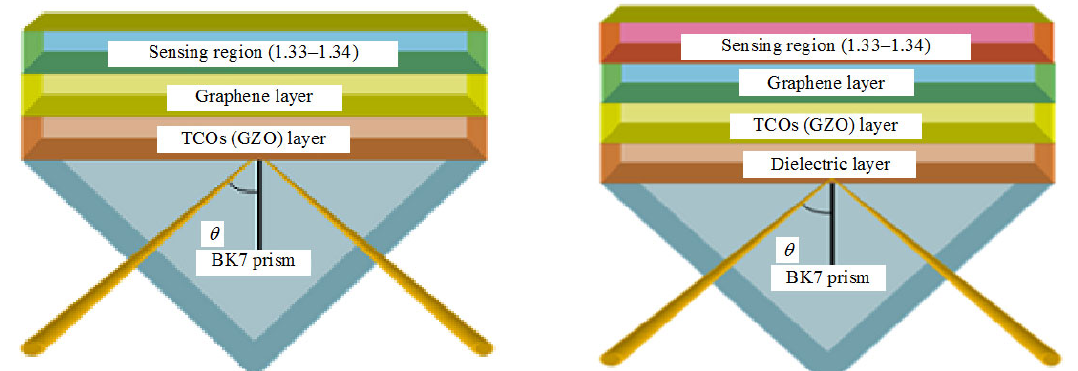
Fig. 1 SPR sensor design: (a) prism/GZO/graphene/sensing medium and (b) prism/dielectric/GZO/graphene/sensing medium.